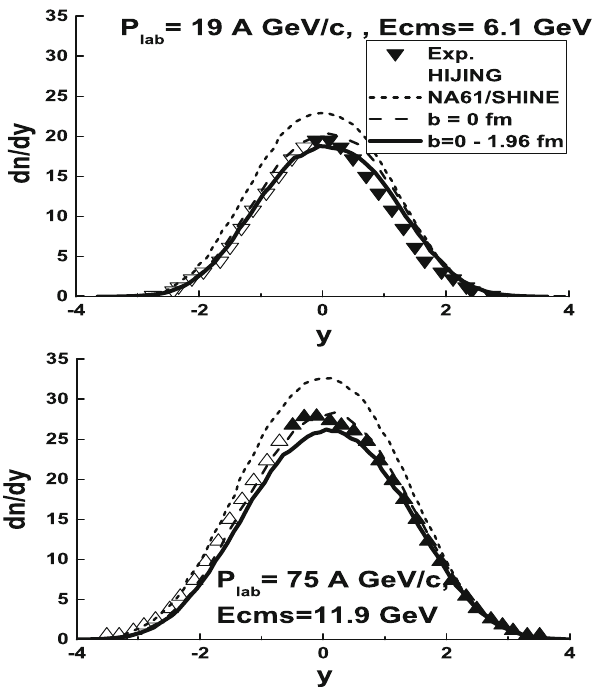
Fig. 2 Rapidity distributions, d n /d y , of π − mesons in 40 Ar + 45 Sc interactions. The black points are the data measured by the NA61/SHINE collaboration for 0–5% centralities. The open points are the values extrapolated by the collaboration into an unmeasured region.